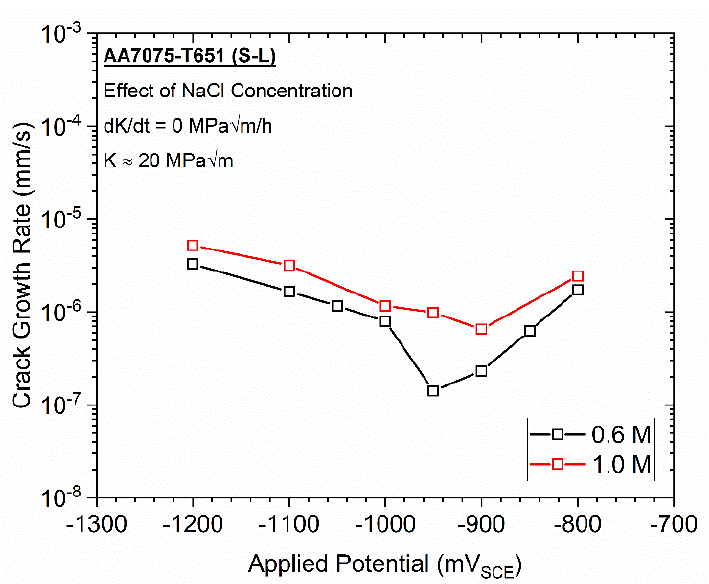
Figure 3. Measured crack growth rate as a function of applied potential for AA7075-T651 in 0.6 M NaCl (black squares) and 1.0 M NaCl (red squares) at a fixed K = 20 MPa √ m.